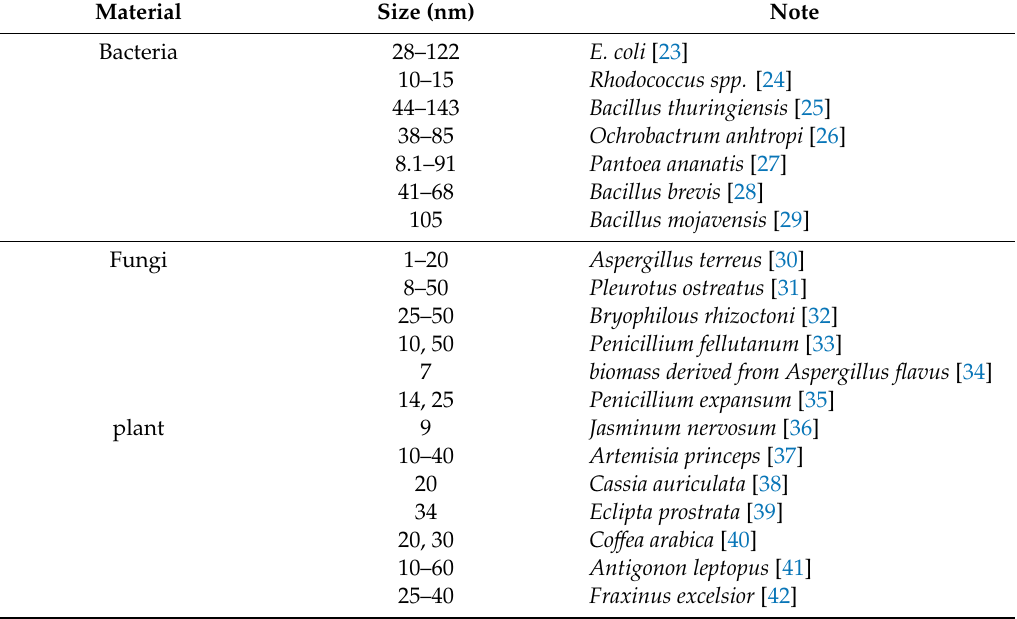
Table 1. Some green synthesis methods for synthesizing Ag